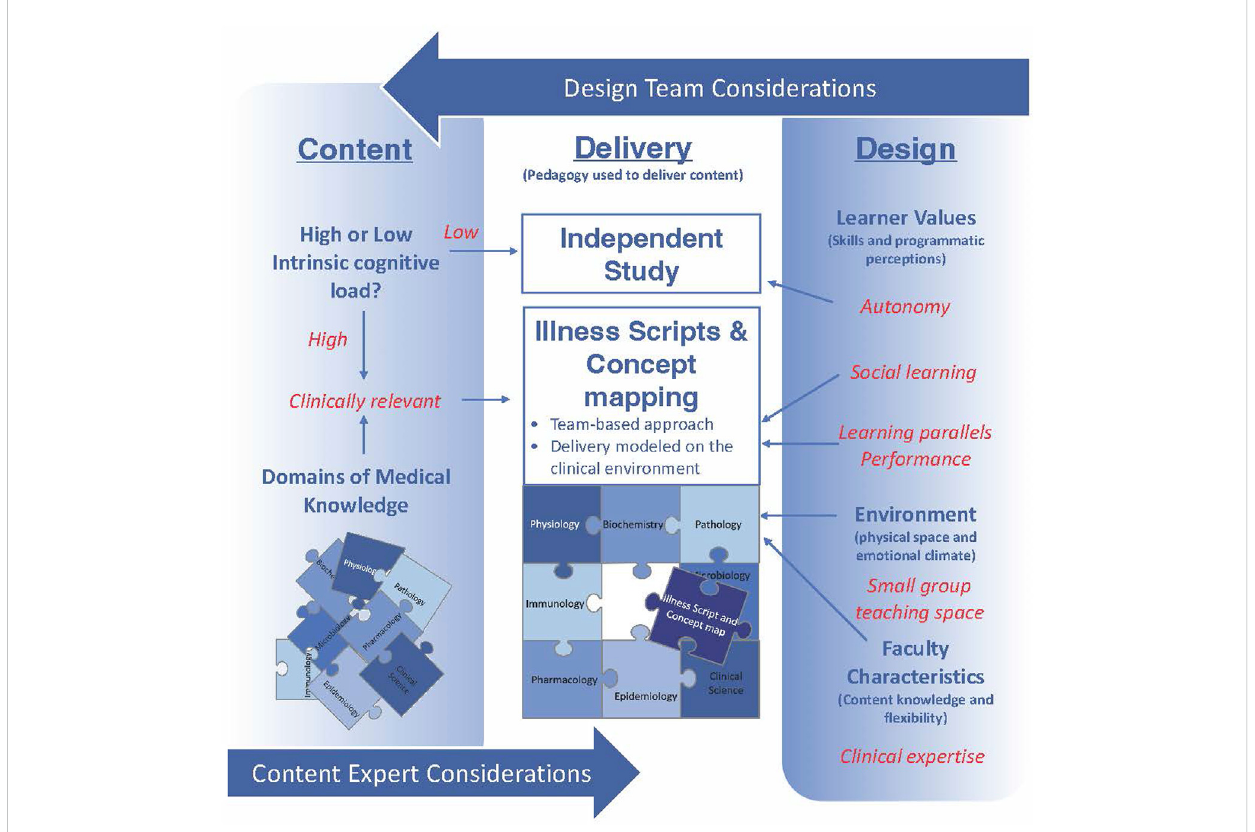
FIGURE 1 A schematic representation of elements to consider in the generation of an integrated curriculum. Beyond considering the speci fi c content to include (left column) there are design elements that are integral to implementing a curriculum aligned with learner characteristics, resources and faculty (right column). Considering both content and design elements promotes selection of pedagogies (center column) that are best suited to achieve educational goals. Red text indicates elements speci fi c to our model that may not be the same in other learning